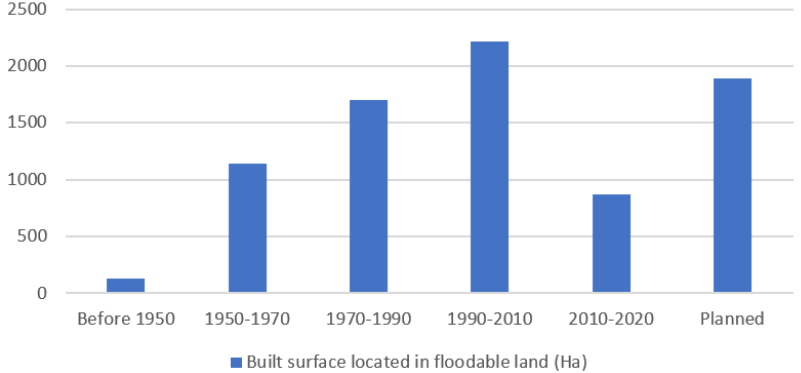
Figure 7. Breakdown of the surface areas built in the different decades in areas currently determined as flood-prone areas in the metropolitan area of the city of Murcia.